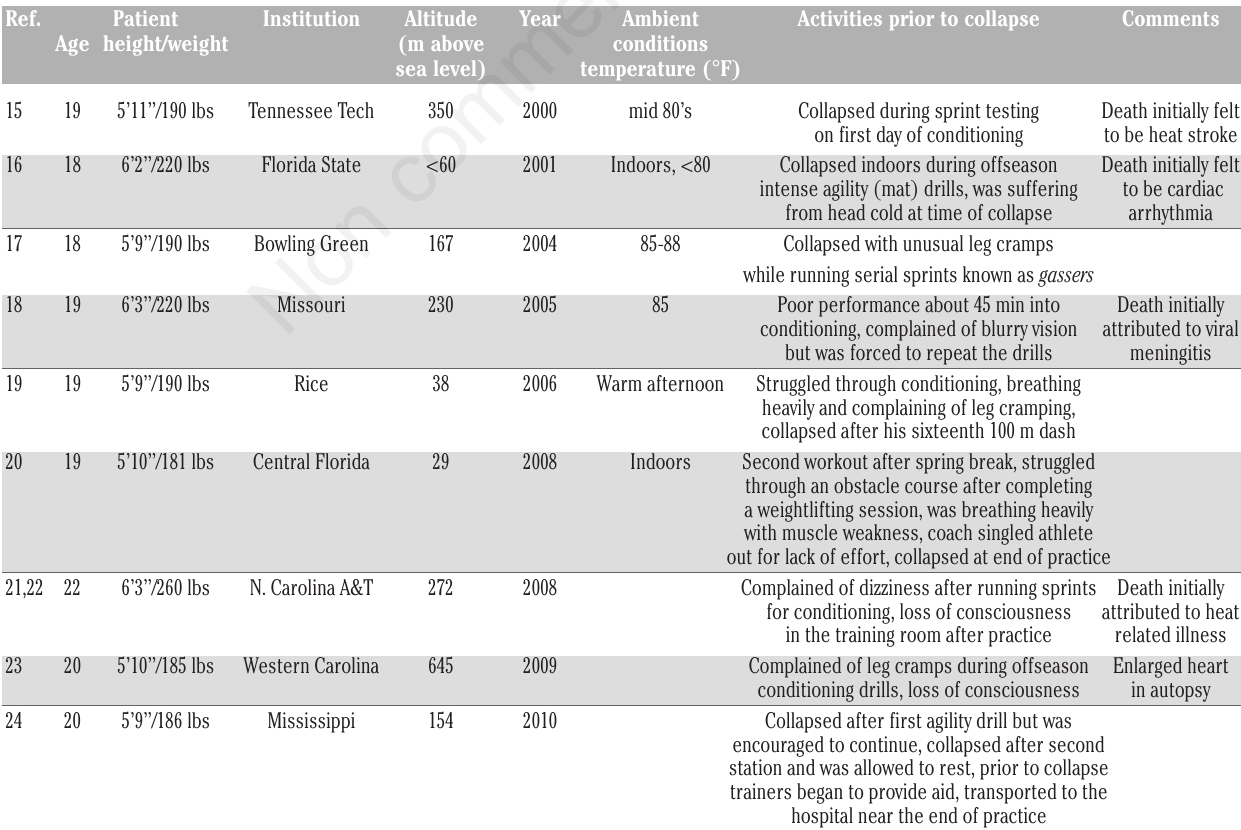
Table 1. Cases of fatal, exercise collapse in college football players with sickle cell trait.